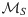
Correlation between (a) MG vs TC, (b) MG vs GC and (c) TC vs GC.We use ℳS and we remove 57, 161 pairs that were not computed after 20 seconds in GC.